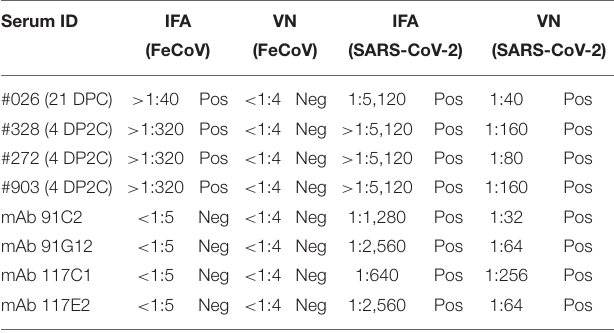
TABLE 7 | Cross-reactivity of SARS-CoV-2-positive cat serum samples and SARS-CoV-2 RBD-specific monoclonal antibodies with FeCoV. Serum ID IFA VN IFA VN (FeCoV) (SARS-CoV-2)